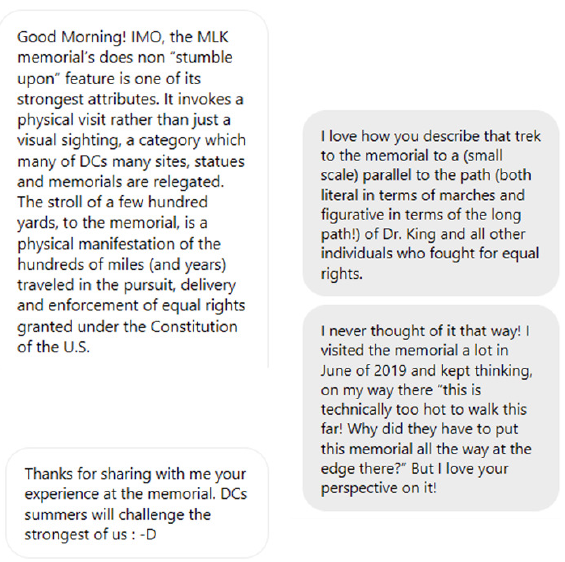
Figure 6. Interviewer reactions in